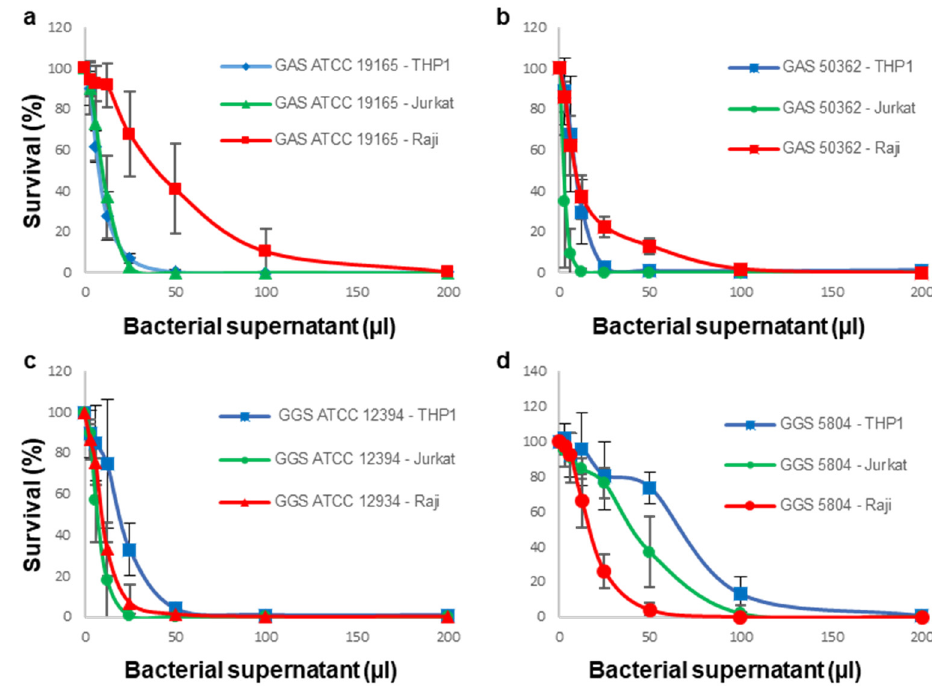
Figure 1. Different types of immune cells display different sensitivities to filtered bacterial supernatants. The GAS ATCC 19165 supernatant is more toxic to THP-1 and to Jurkat cells than to Raji cells ( a ). The GAS 50362 supernatant is more toxic to Jurkat cells compared to THP-1 cells; Raji cells are the most resistant ( b ). The GGS ATCC 12394 supernatant shows comparable toxicity towards Raji and Jurkat cells; THP-1 cells are the most resistant ( c ). The GGS 5804 supernatant is more toxic to Raji cells compared to Jurkat cells; THP-1 cells are the most resistant ( d ). Both GAS strains were most effective against Jurkat and THP-1 cells, whereas Raji